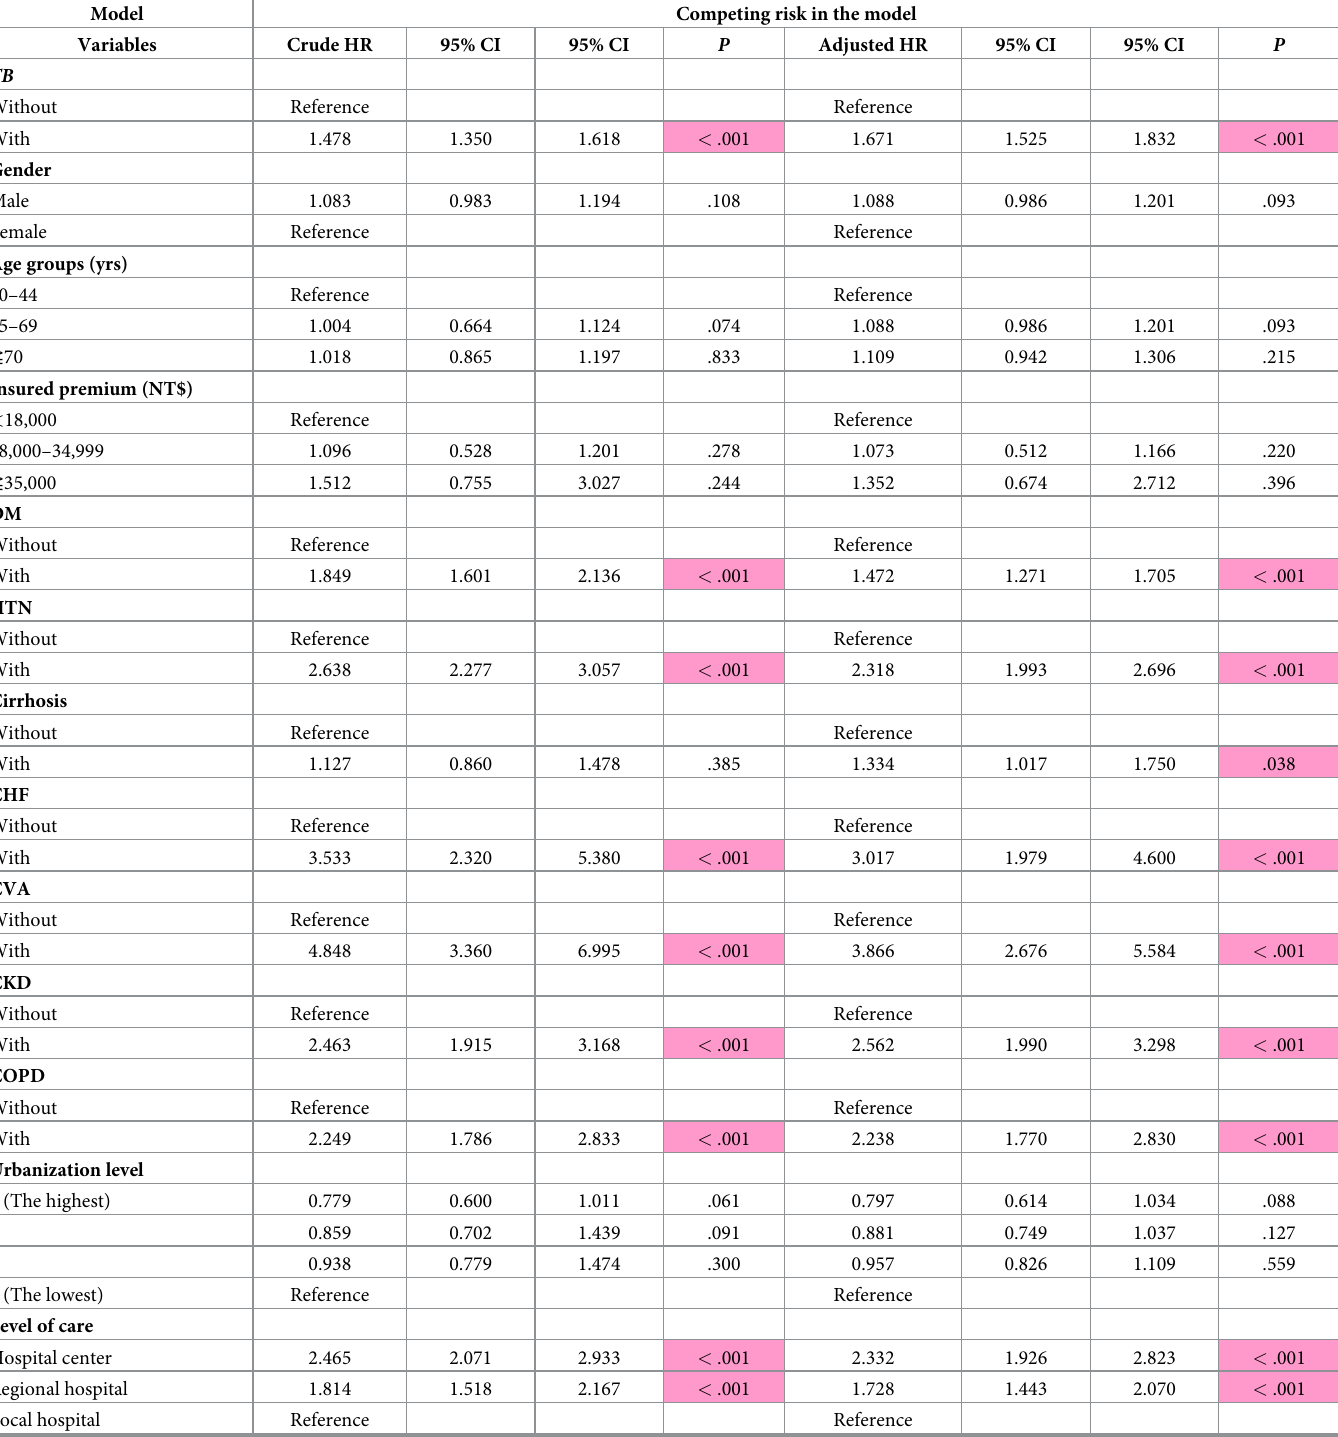
Table 2. Factors of secondary lung cancer using Cox regression and Fine & Gray’s competing risk